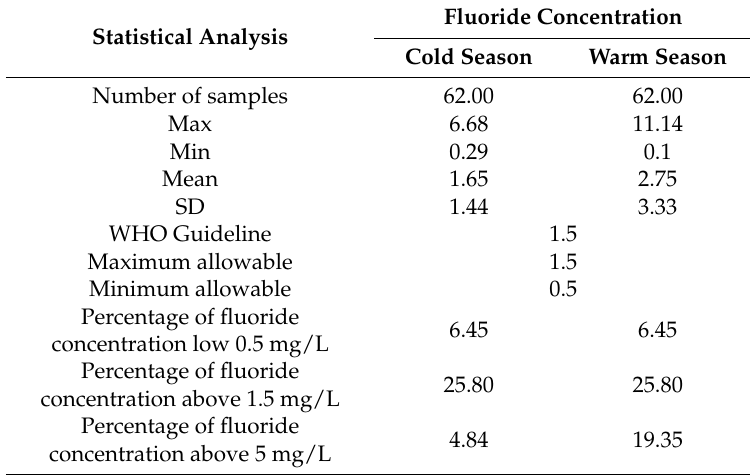
Figure 2. Spatial distribution of fluoride in groundwater in the studied areas in cold and warm seasons. Table 3. The fluoride concentration (mg/L) in drinking water sources of the studied area, expressed as means ± standard deviation, min and